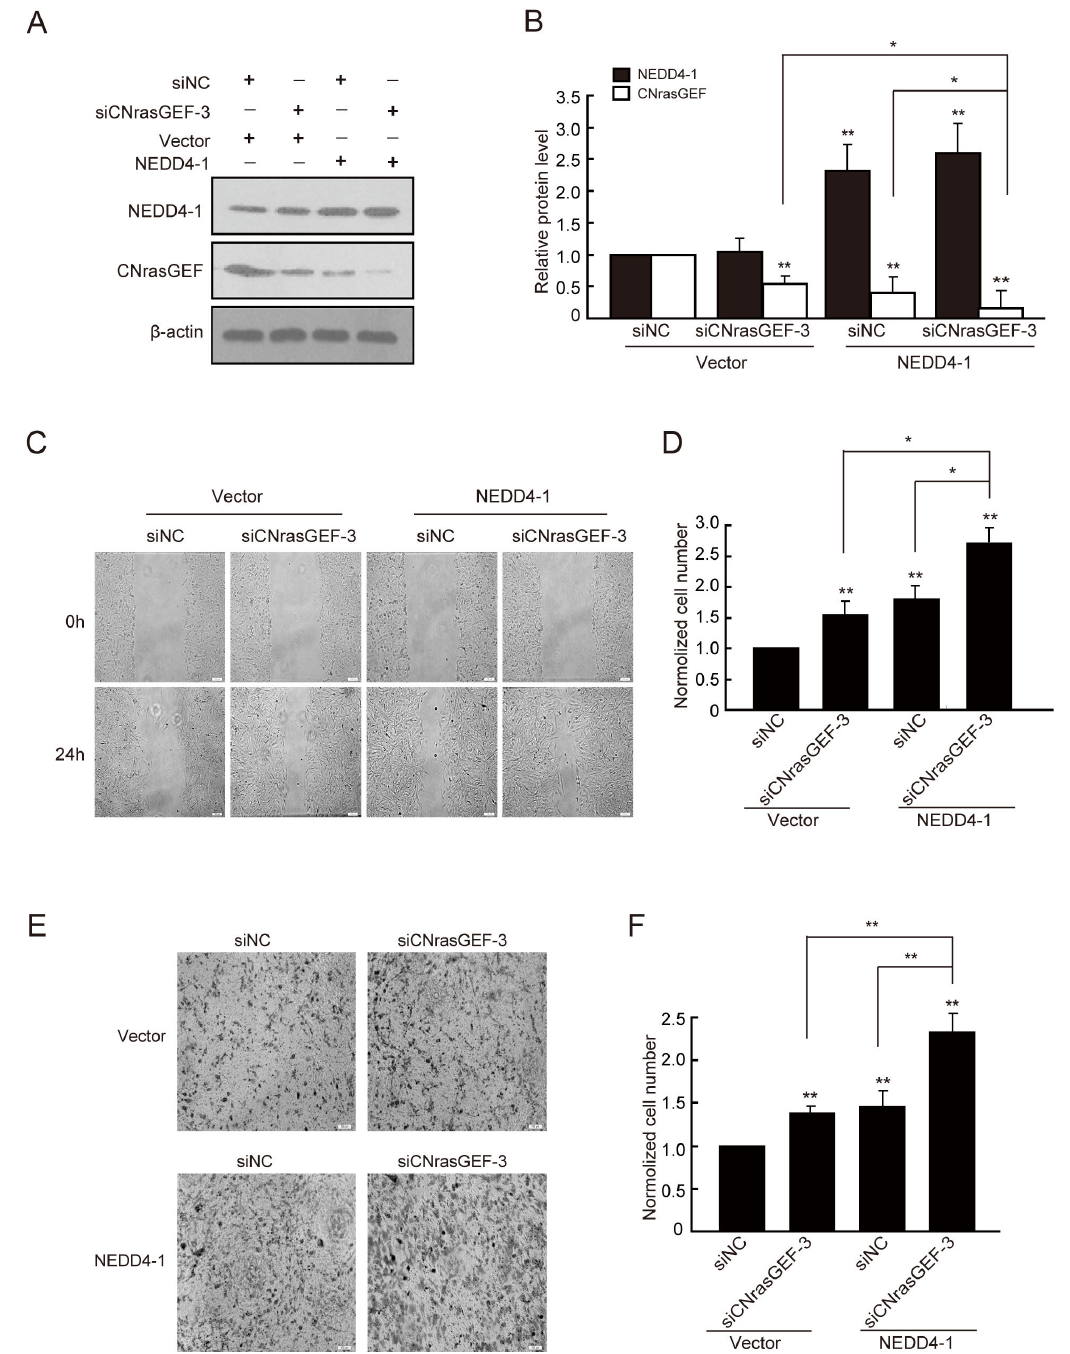
Figure 4. CNrasGEF downregulation facilitates the promotion effect of NEDD4-1 on cell migration and invasion. A) Western blotting showed the expression of NEDD4-1 and CNrasGEF after co-transfection in U251 cells. Representative western blotting analysis of total cell lysates isolated from U251 cells co-transfected with NEDD4-1 and siCNrasGEF using indicated antibodies. B) Quantitative analysis of relative protein levels of NEDD4-1 and CNrasGEF normalized to those of β-actin. C) Wound- healing assays of glioma U251 cells after co-transfection of NEDD4-1 and siCNrasGEF. Representative digital pictures were taken at 0h and 24h. D) Quantitative analysis of the number of migratory cells. E) Transwell invasion assays of glioma U251 cells after co- transfection of NEDD4-1 and siCNrasGEF. F) Quantitative analysis of the number of invasive cells. Results are mean ± SEM of three independent experiments in triplicate. * P <0.05, ** P <0.01. Scale bar: 100μm. doi: 10.1371/journal.pone.0082789.g004 PLOS ONE |